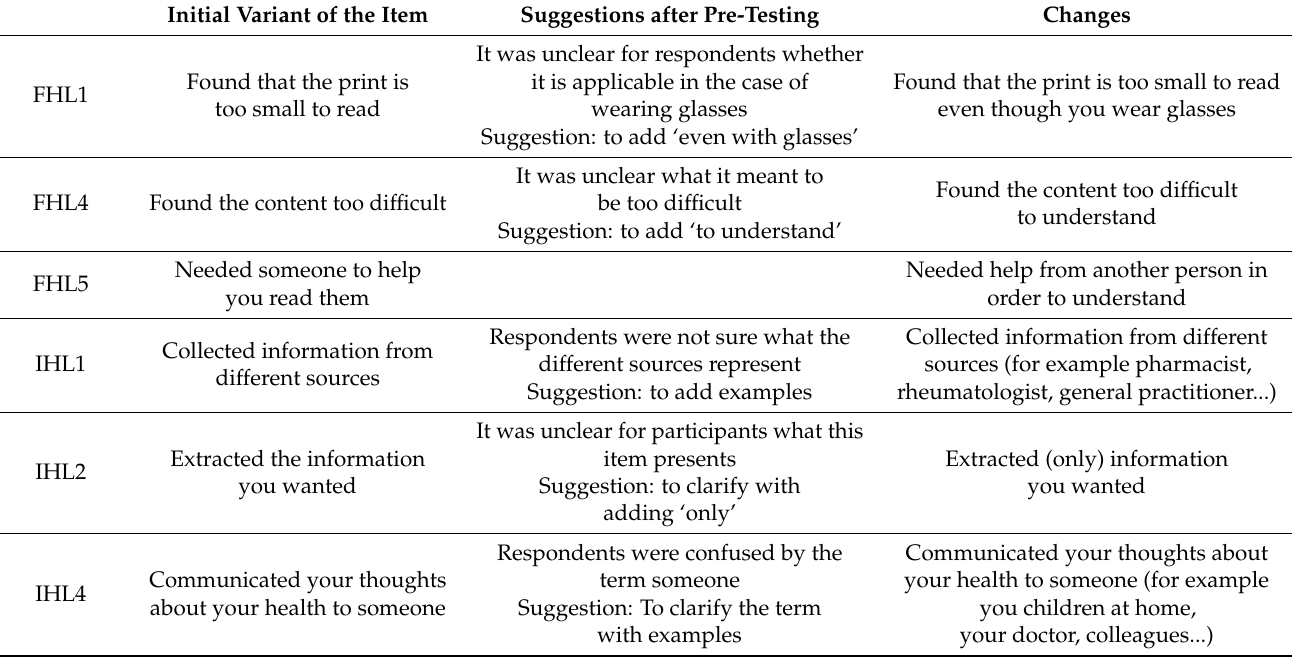
Table 1. Cultural adaptation of the items from the FCCHL-SR14 instrument included in the discussion after